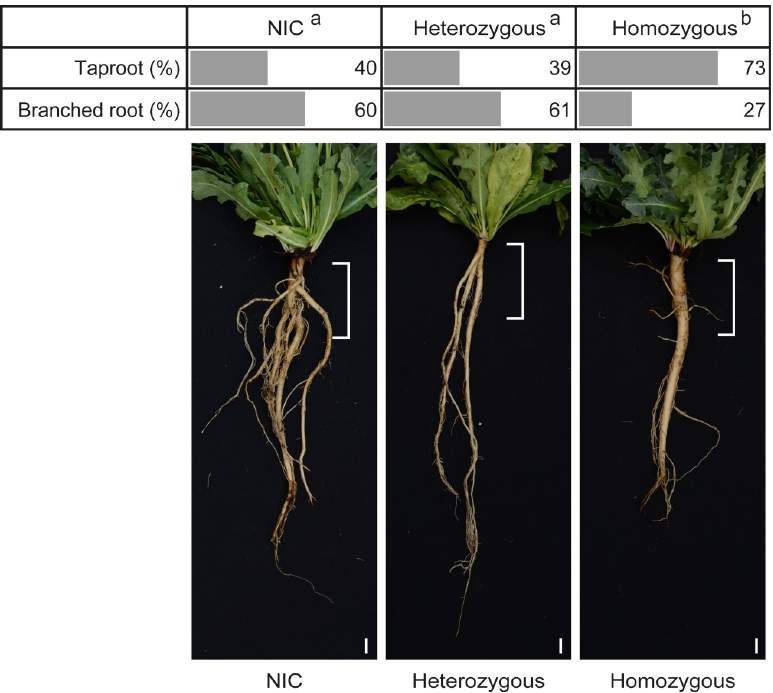
Fig 6. Effect of TkRALFL1 knockout by CRISPR/Cas9 on primary root phenotype of adult T . koksaghyz plants. Evaluation of the root phenotype of 12-week-old plants from the BC1 generation of the TkRALFL1 CRISPR/Cas9 experiment; n = 10 for NIC plants, n = 23 for heterozygous plants, n = 15 for homozygous plants. Length of the bar depicts the percentage occurrence of the taproot phenotype in the individual plant categories. The root system of representative plants in each of the three categories are shown below. The white bracket at the top end of the root indicates the 5 cm section that was evaluated to determine the root phenotype, and for measuring the primary root volume described in Table 1. Pearson’s chi-square test was used to evaluate differences in root phenotype frequency between two plant groups, and differences are depicted by different letters, with p < 0.1; Scale bar = 1 cm.